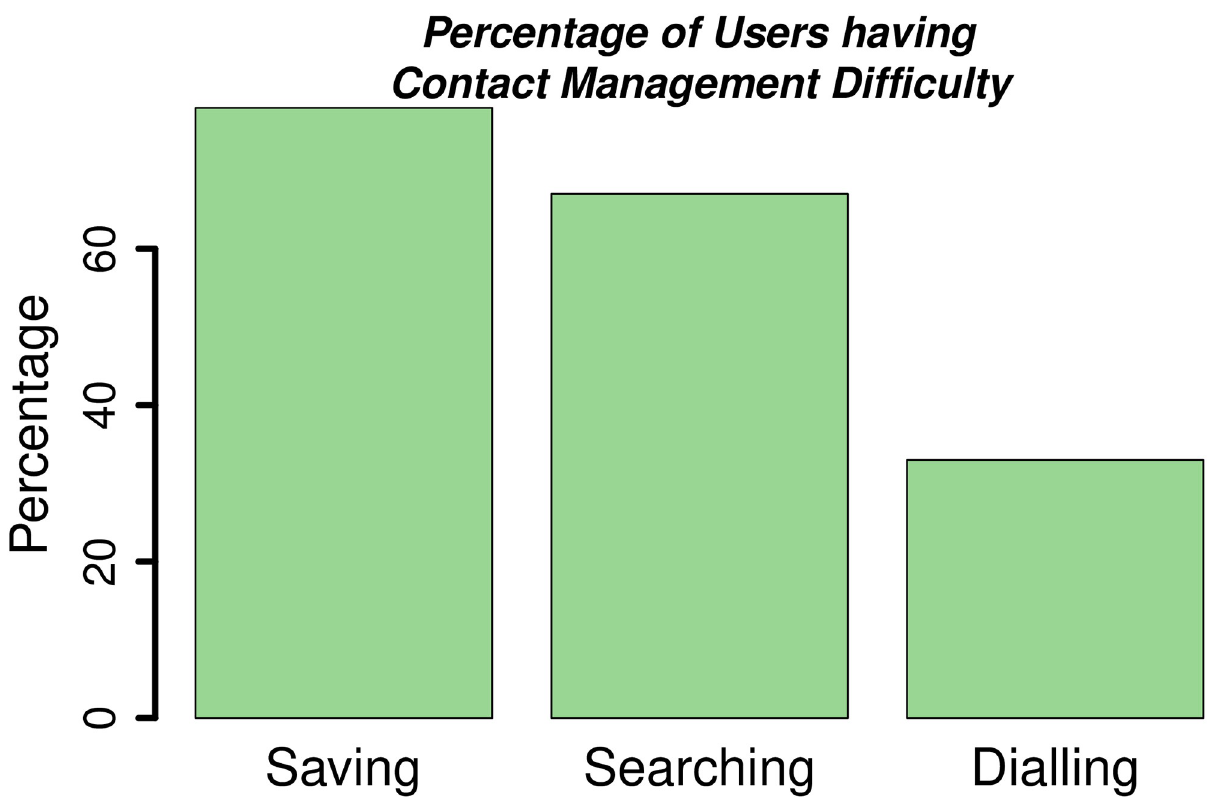
Fig 4. Subjective responses of emergent users about the usability of current contact-book and call log interface. It can be clearly seen that almost 80% users had difficulty in saving a contact, almost 70% in contact search, and more than 30% also had difficulty in dialling a contact number. Hence, the subjective responses of controlled experiment’s participants also indicate the severity of usability issues in the contact management on traditional smartphone interface, by illiterate users.